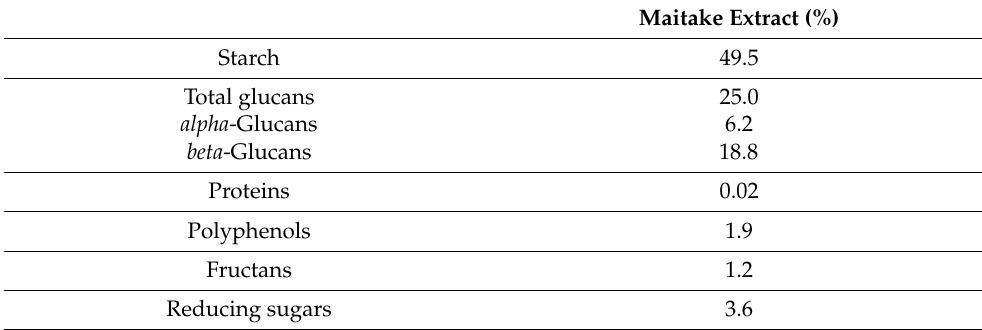
Table 2. Composition of Maitake extract used in this